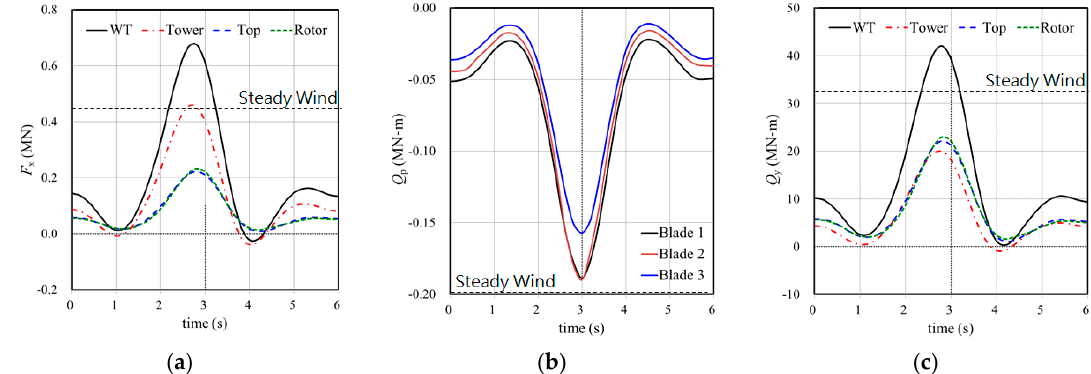
Figure 16. Time history of wind load for the blade configuration of 0°–120°–240°: ( a ) 𝐹 (cid:2934) ; ( b ) 𝑄 (cid:2926) ; ( c ) 𝑄 (cid:2935) .